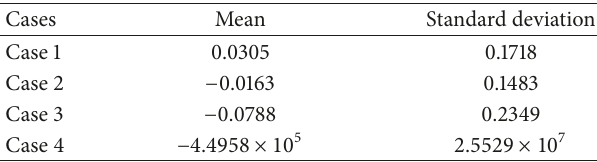
Table 2: Comparison results of the tracking errors among the four